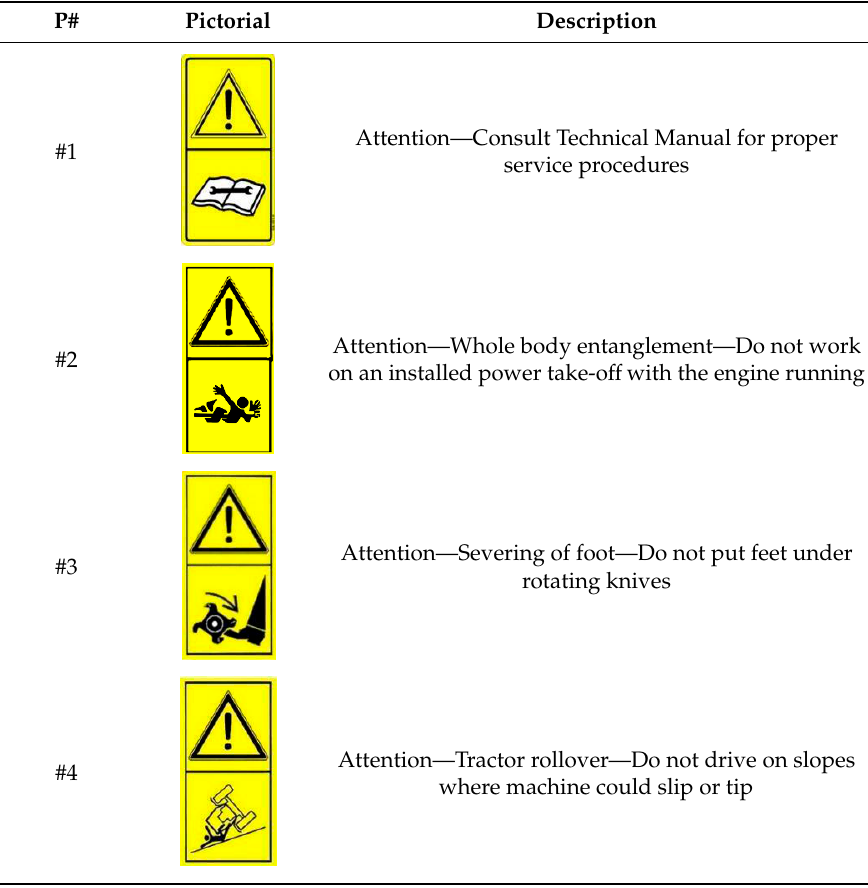
Table 1. Safety pictorials and their meanings (from ISO 11684:1995).